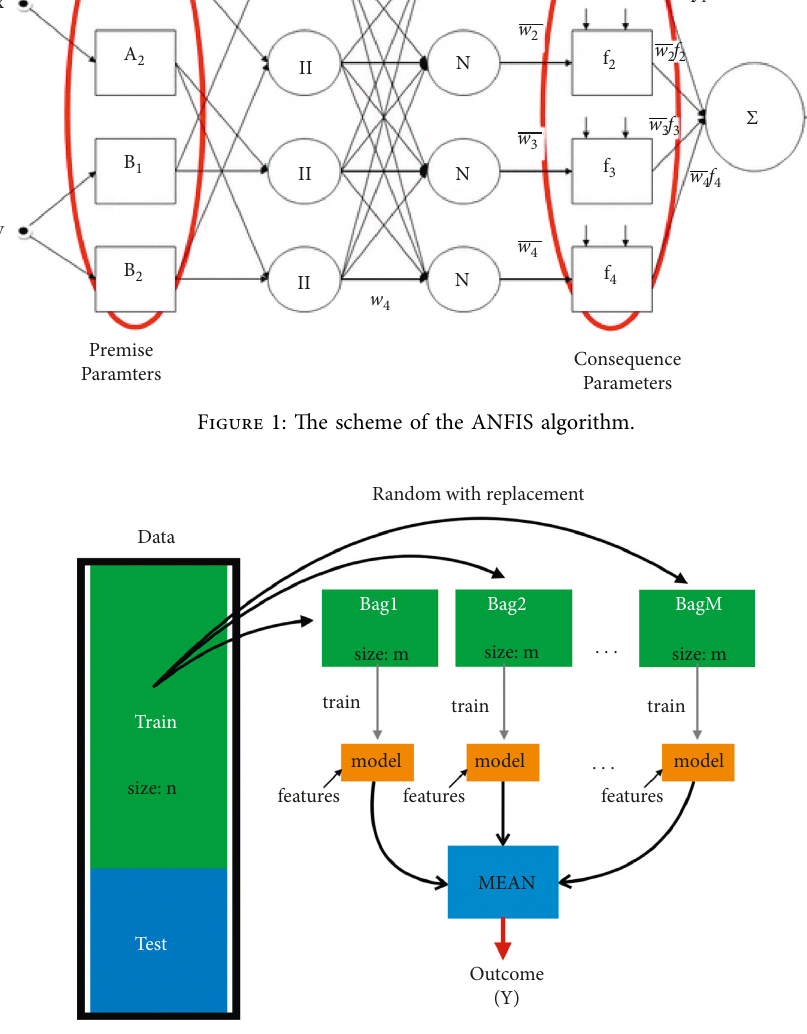
Figure 2: The scheme of the bagging process.